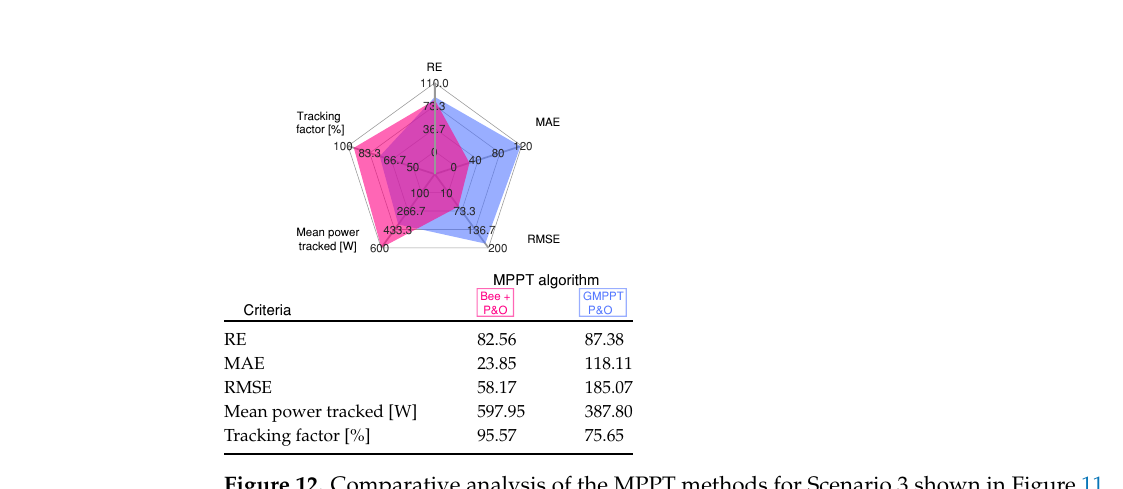
Figure 12. Comparative analysis of the MPPT methods for Scenario 3 shown in Figure